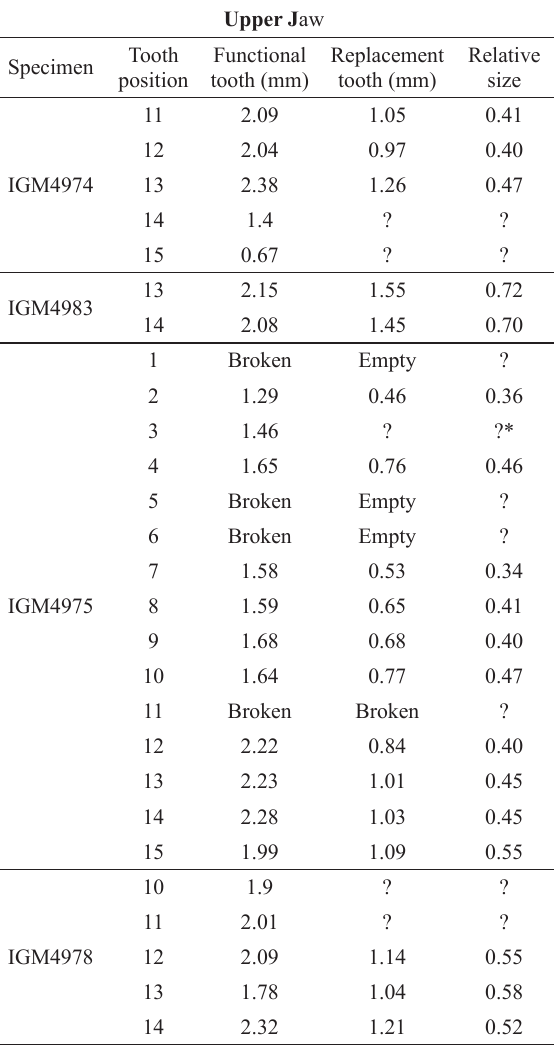
Relative tooth sizes.